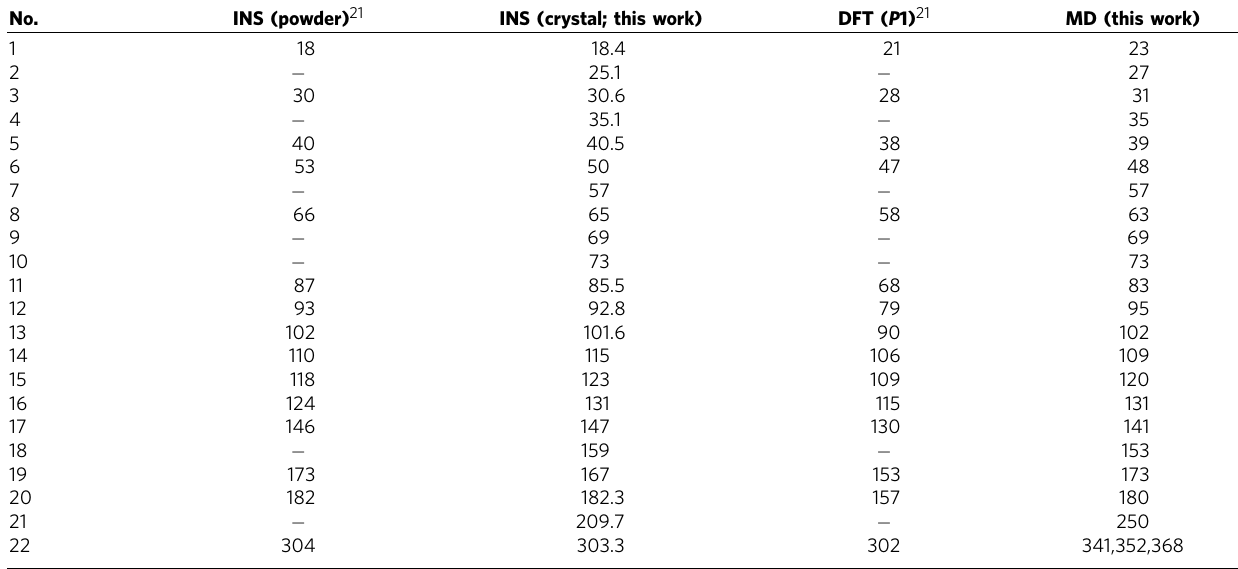
Table 1 | Comparison of frequencies (in cm (cid:2) 1 ) of typical optical phonon modes.